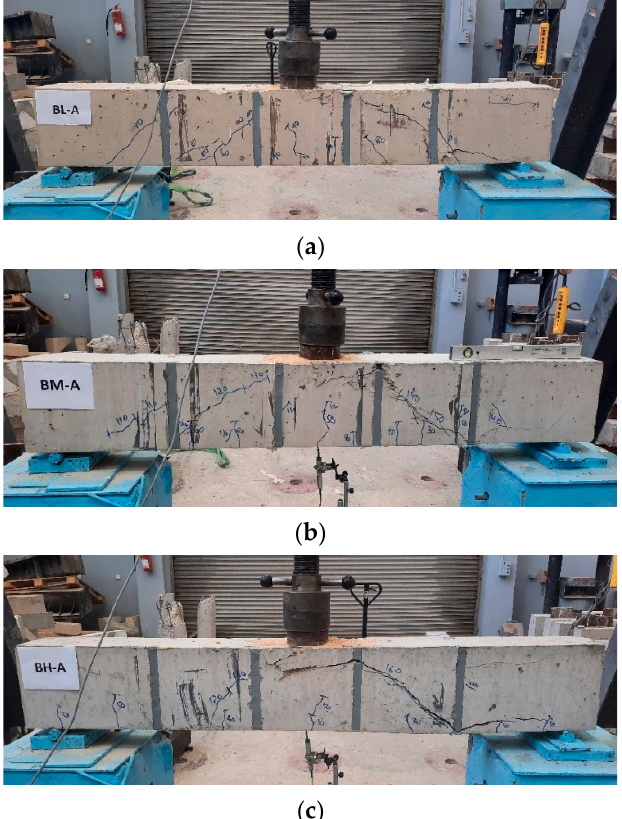
Figure 9. Failure modes of beams with aligned NSM-CFRP strips: ( a ) BL-A, ( b ) BM-A, and ( c ) BH-A. For beams with one unaligned NSM-CFRP strip between any two internal stirrups, the shear crack did not start until after the first NSM-CFRP strip. However, after the shear crack appeared, the same behavior as the beams with aligned NSM-CFRP strips was observed, and the cracks propagated behind the NSM-CFRP strips to reach the loading point. As mentioned before, the inclination of the cracks changed since the NSM-CFRP strips interrupted the cracks while propagating. Figure 10 shows the failure modes of beams with one unaligned NSM-CFRP strip between the internal stirrups.